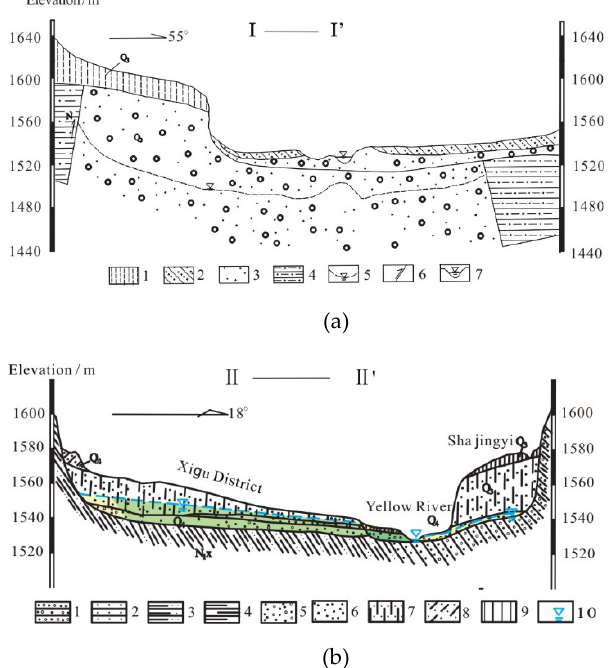
Figure 2. Hydrogeological profile of the study area. ( a ) Hydrogeological profile of the study area